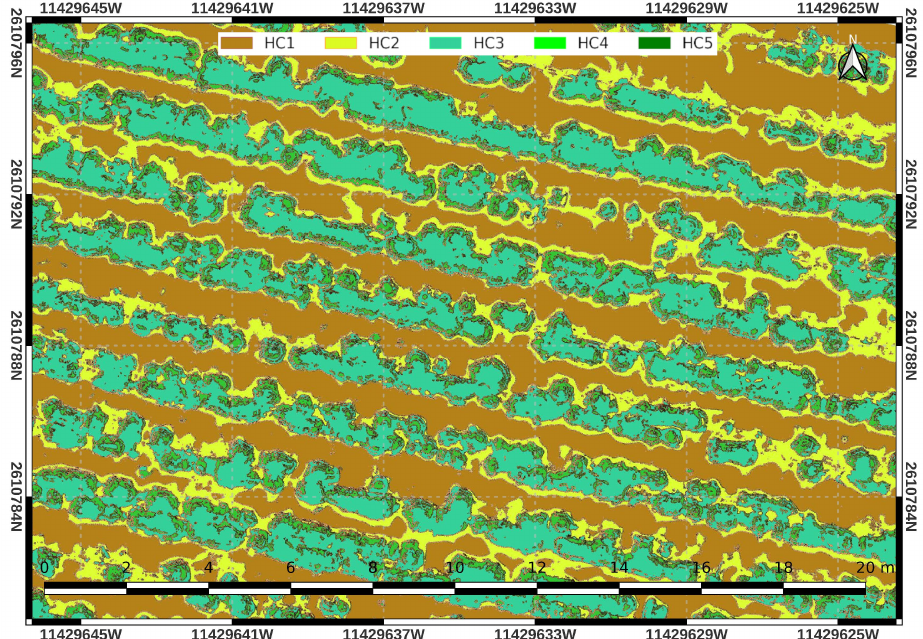
Figure 14. Segmentation with random forest classifier on local image features at orthomosaic level area.